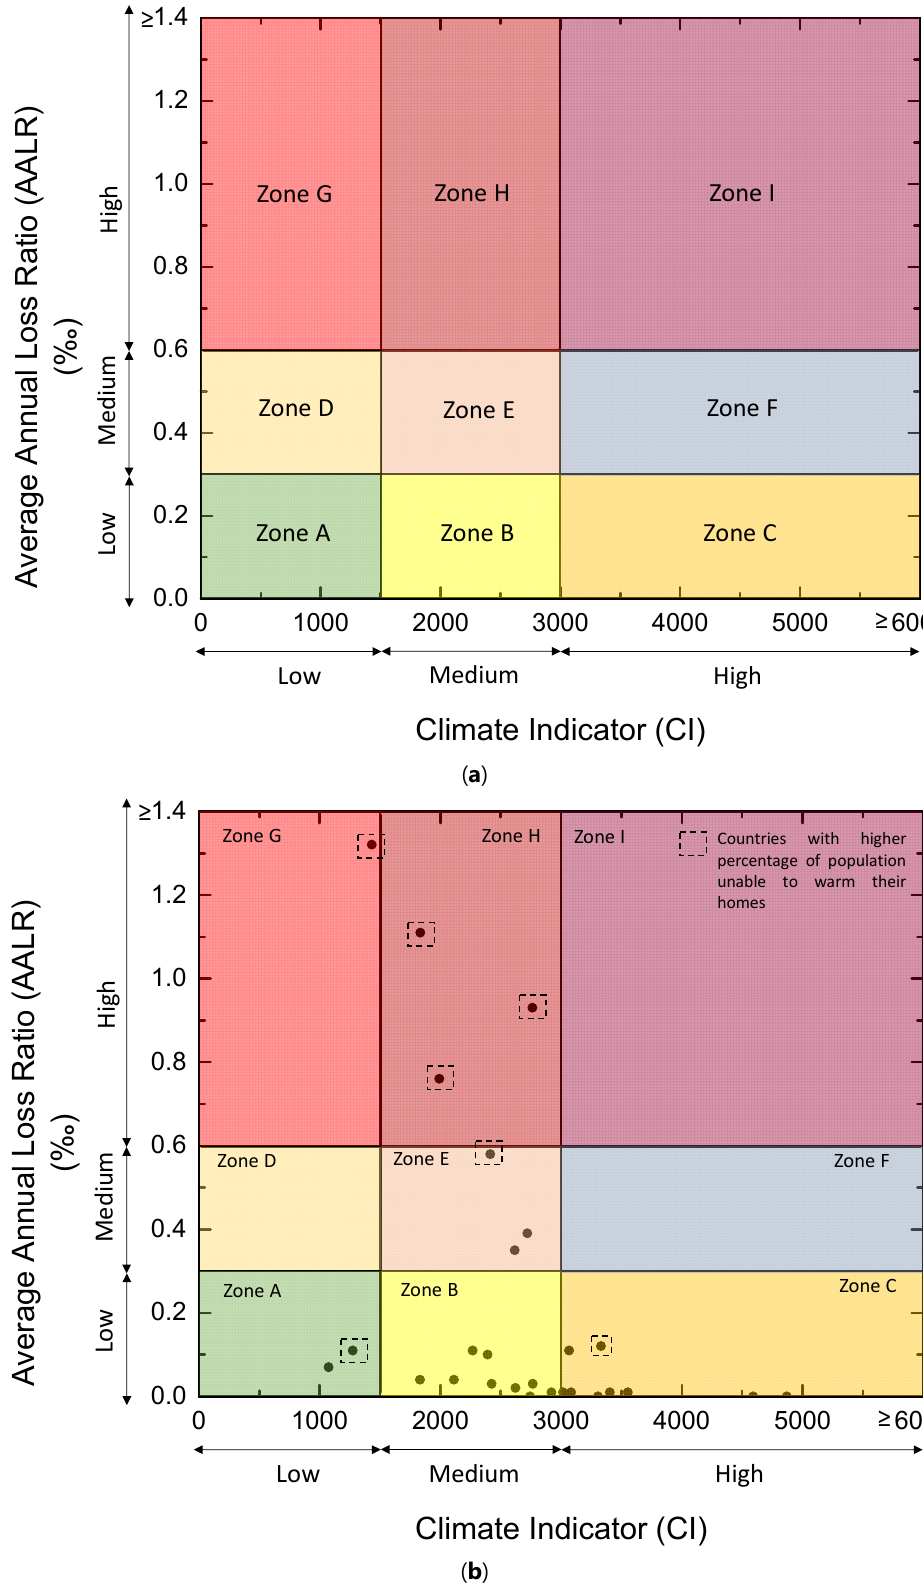
Figure 8. Seismic–climate zone matrix: ( a ) schematic layout; ( b ) average country values.